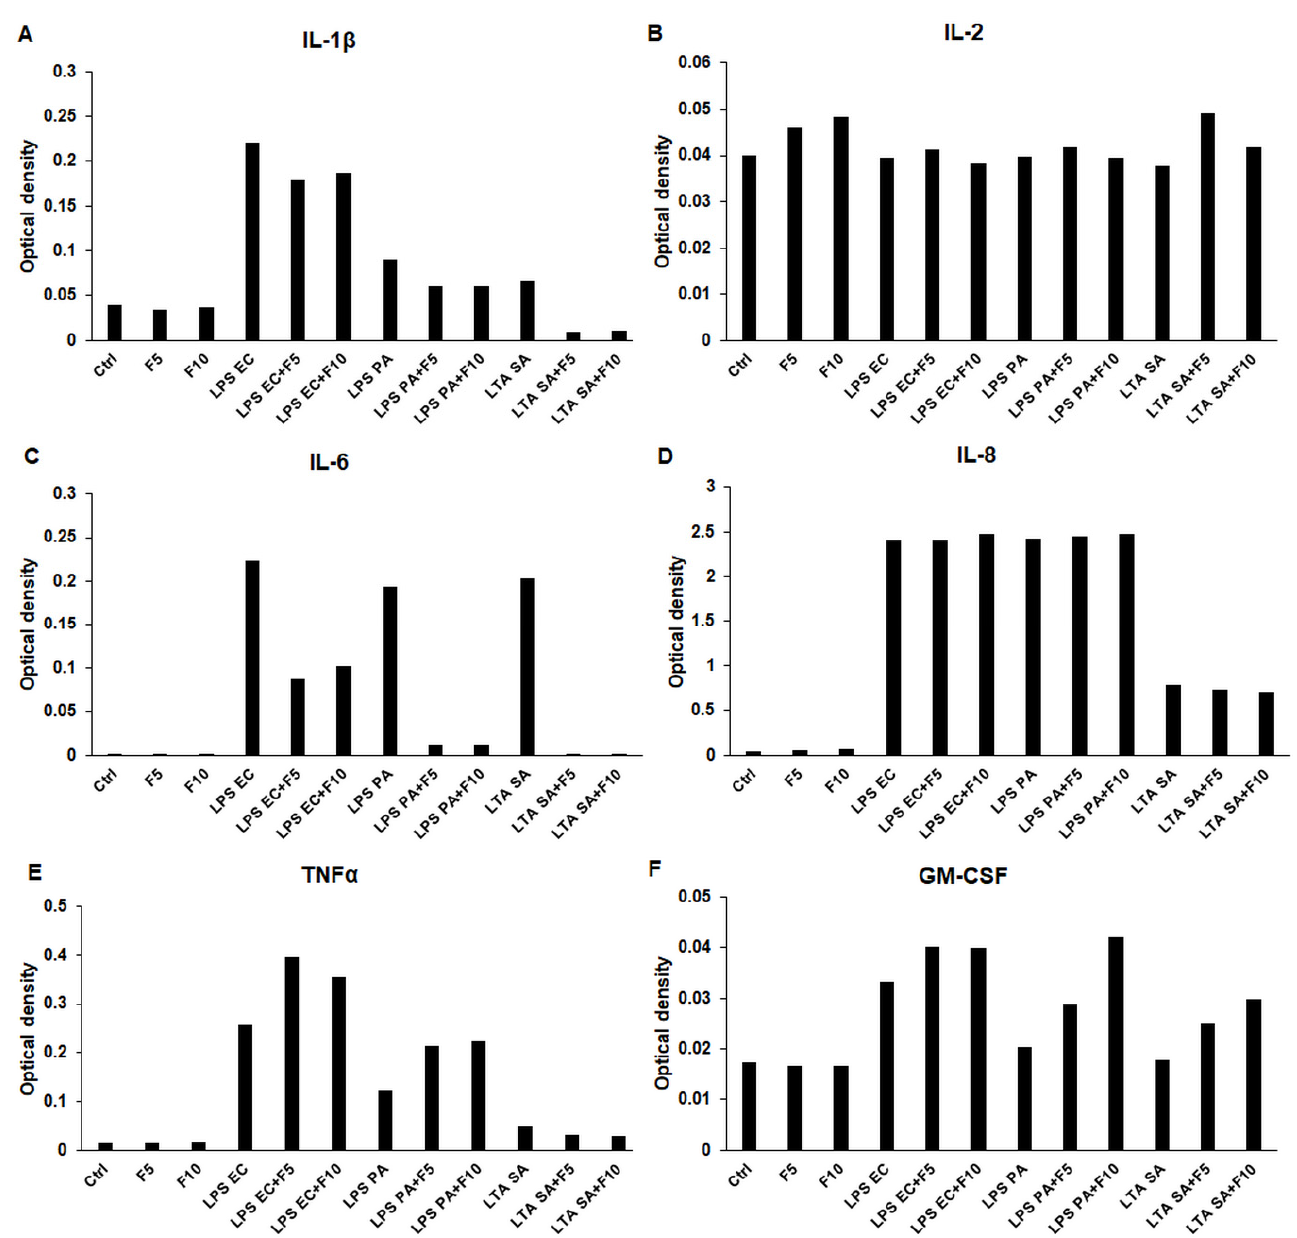
Figure 1. ELISArray determination of pro-inflammatory cytokine production of E. coli or P. aeruginosa LPS and S. aureus LTA and/or fractalkine-treated THP-1 cells. The arrays were carried out using pooled cell culture supernatants obtained from the same treatment types of four independent experiments ( n = 4). In the case of co-treatments, both the LPS or LTA and fractalkine were added at the same time to the cells. Supernatants were collected after 24 h of treatments. The columns show the optical density of the average Il-1 β ( A ), IL-2 ( B ), IL-6 ( C ), IL-8 ( D ), TNF α ( E ) and GM-CSF ( F ) production of THP-1 cells. Abbreviations: F5—fractalkine 5 ng/mL; F10—fractalkine 10 ng/mL; LPS